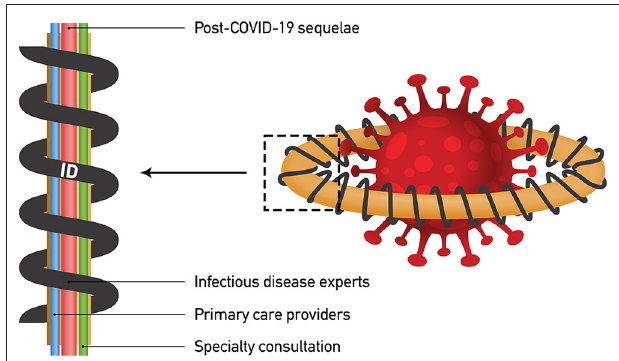
FIGURE 1 | Multispecialty approach to confront post-COVID-19